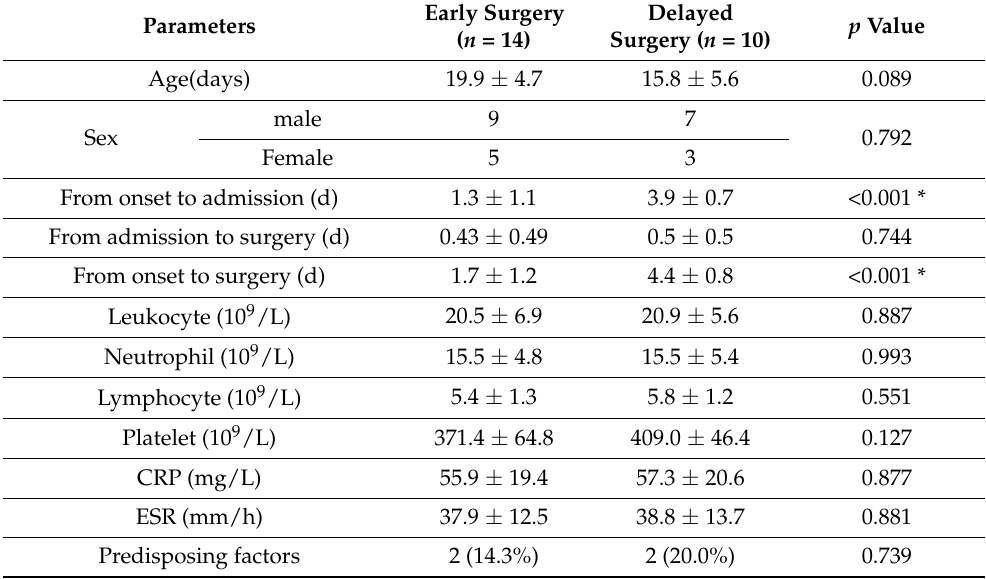
Table 3. Parameters of surgical